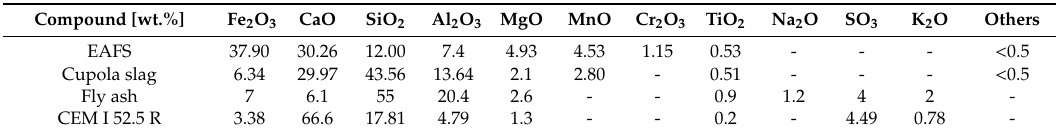
Table 3. Chemical composition of the materials used.